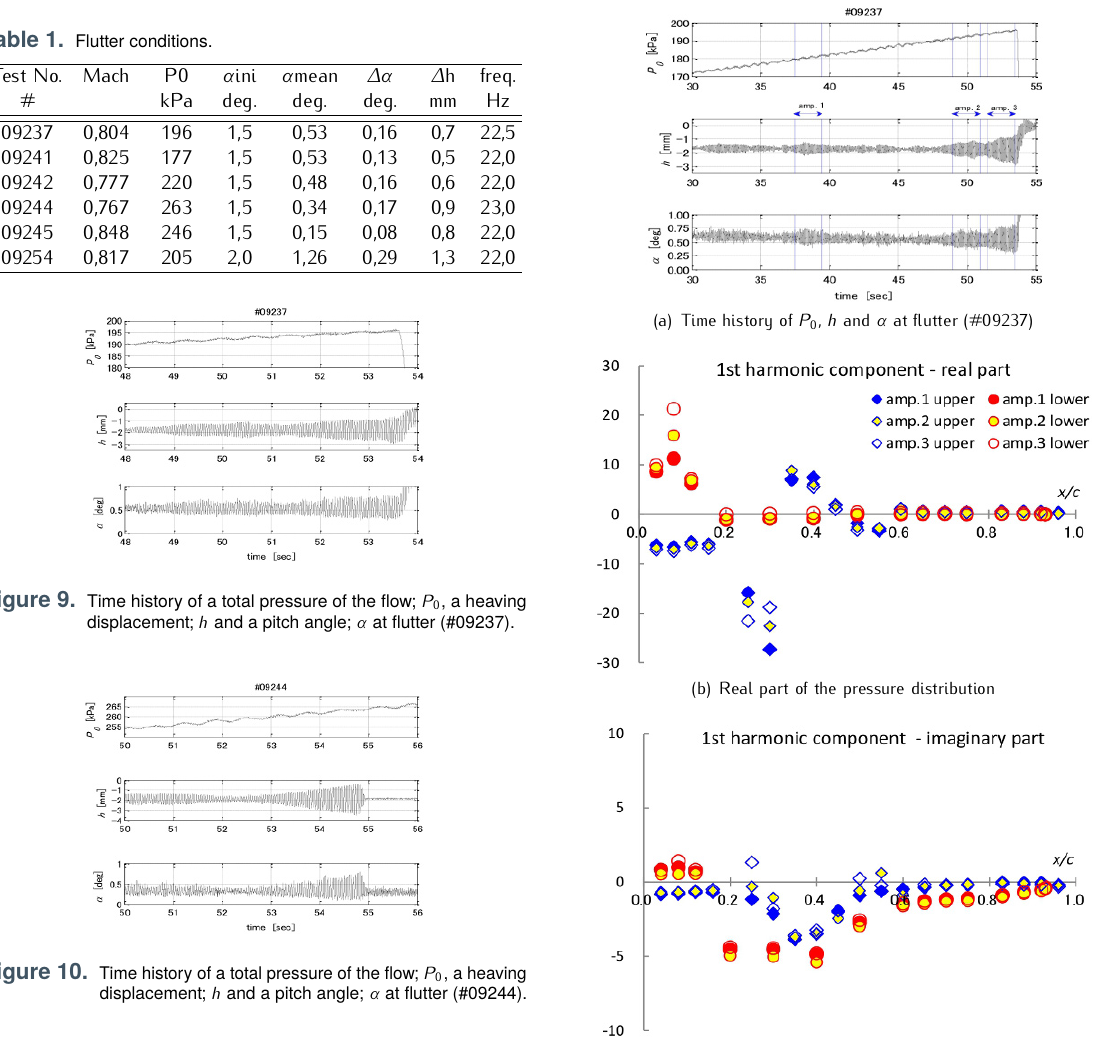
Flutter points were determined while the total pressure of the flow was increasing. Time histories of the total pressure change are shown in Figure 9 and Figure 10 for heaving and pitching, respectively.